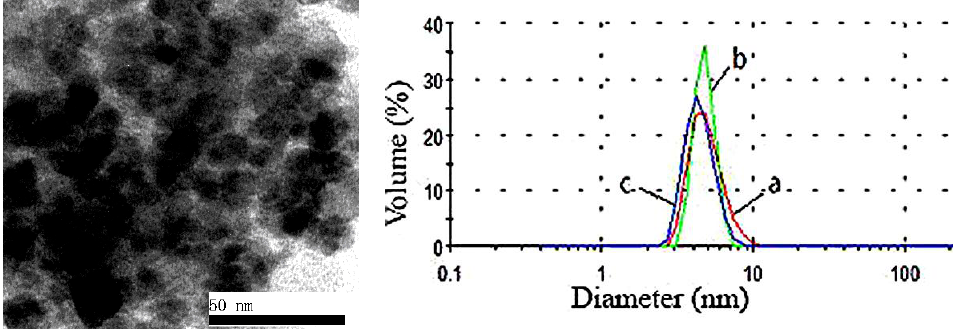
Figure 9. TEM image of γ-Fe 2 O 3 /PANI-curcumin and the particle size distribution image of γ-Fe 2 O 3 ( a ), γ-Fe 2 O 3 /PANI ( b ) and γ-Fe 2 O 3 /PANI-curcumin ( c ).